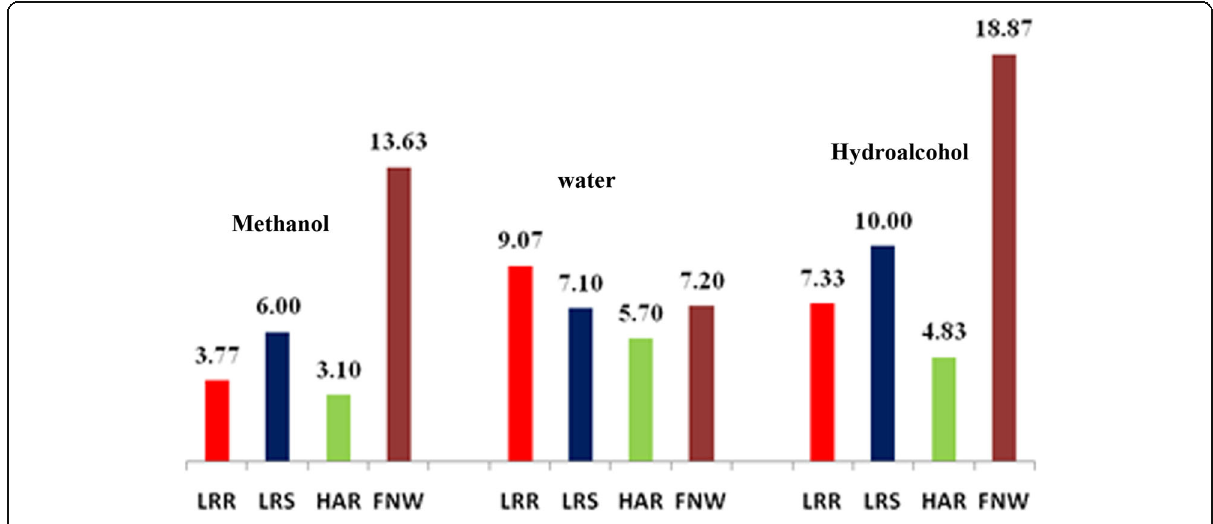
Fig. 1 TPC of various extracts of selected source plants of Jivanti